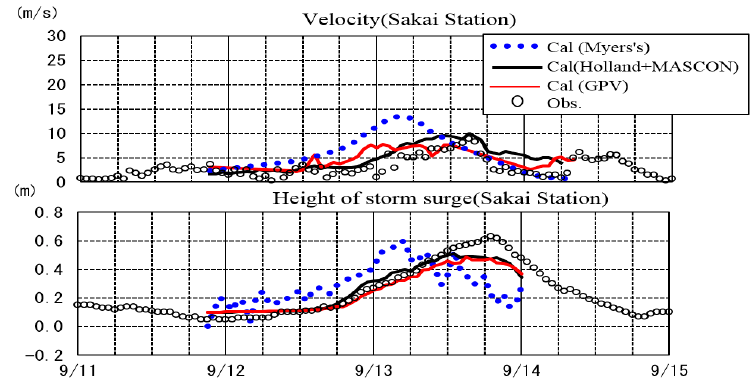
Figure 15. The results of storm surge based on typhoon models (Typhoon No. 14 in 2003).